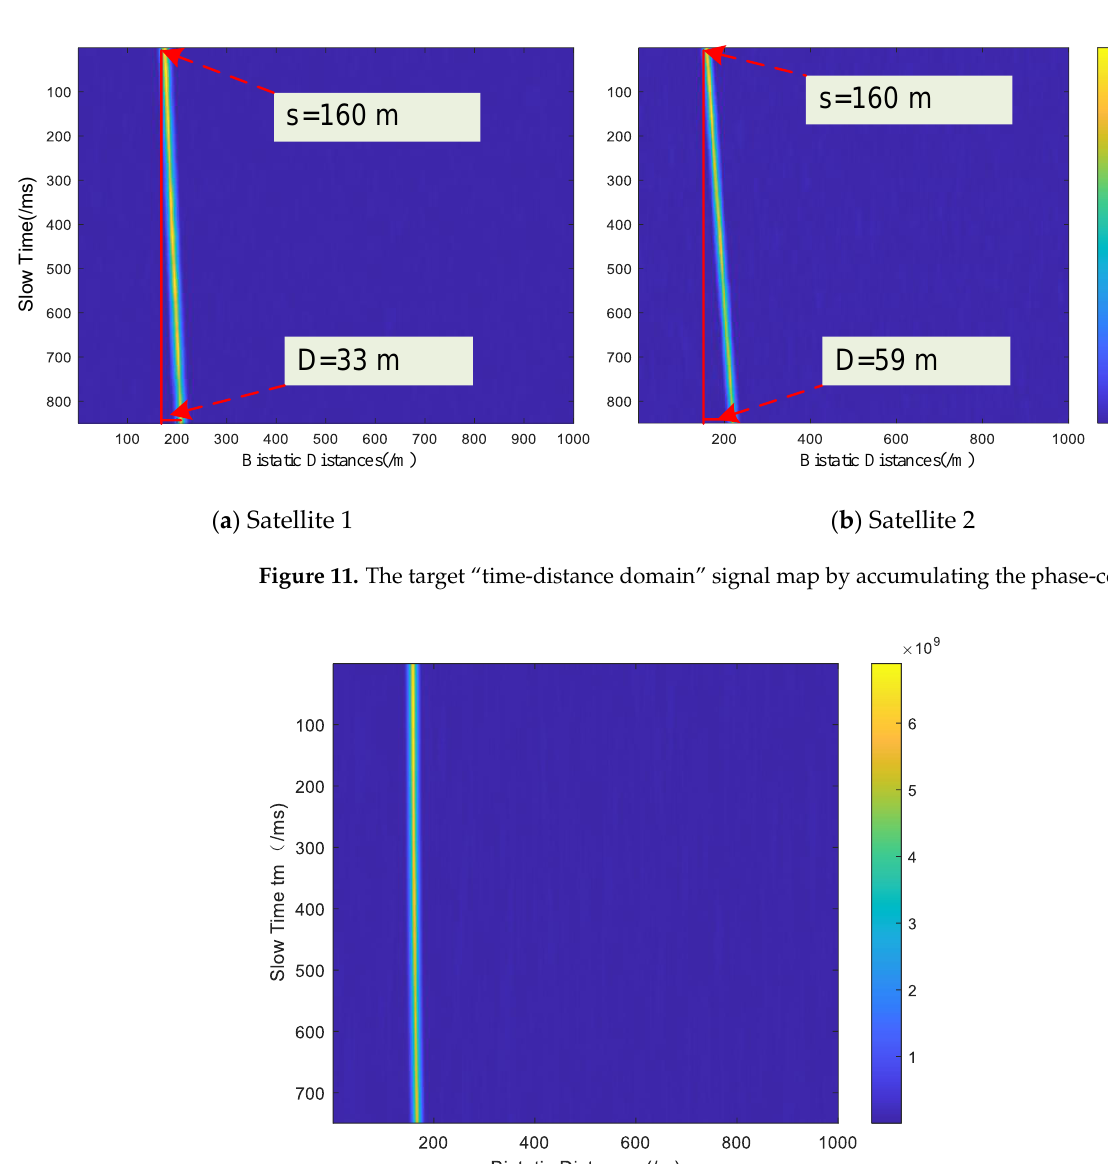
Figure 10. Signal phase diagrams before and after correction.